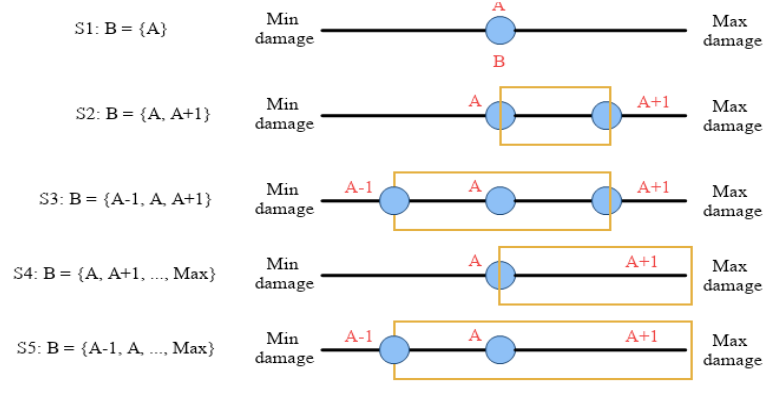
Figure 2. Set representation of each similarity.